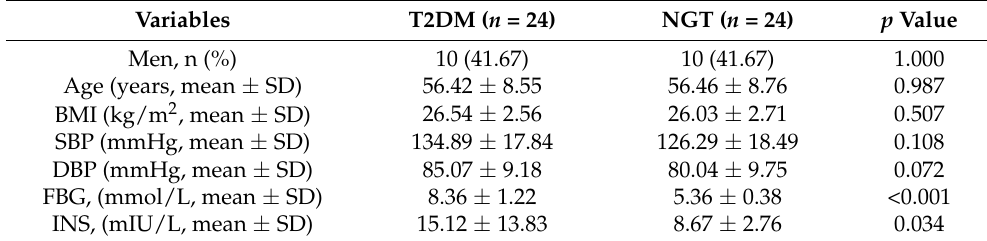
Table 1. Descriptive characteristics of